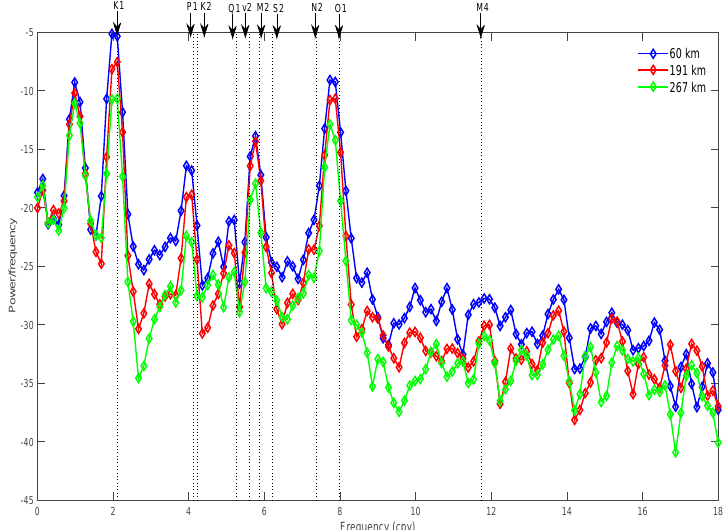
Figure 5. PSD of observed SLA along TOPEX-Jason ground track 240. Points are located at 138°33 ′ 16.20 ″ E, 16°18 ′ 16.92 ″ S (blue curve), 138°7 ′ 57.36 ″ E, 15°14 ′ 9.24 ″ S (red curve), and 137°52 ′ 2.64 ″ E, 14°33 ′ 23.76 ″ S (green curve), around 60 km, 191 km, and 267 km, respectively, from the coast. The aliasing period of the eight main tidal constituents (e.g., M 2 ) and major shallow-water tidal constituent (M 4 ) are shown by arrows.